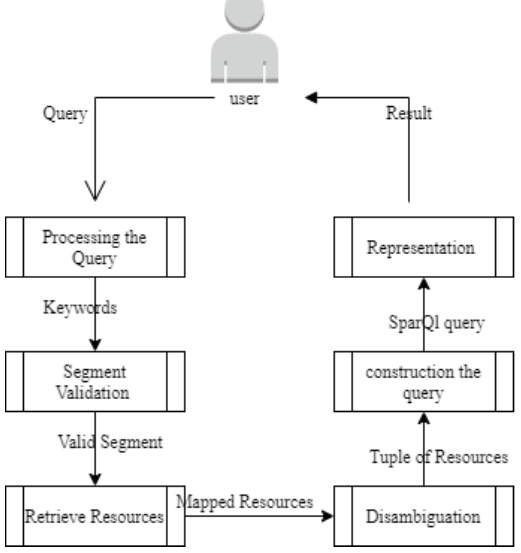
Figure 9. Architecture of